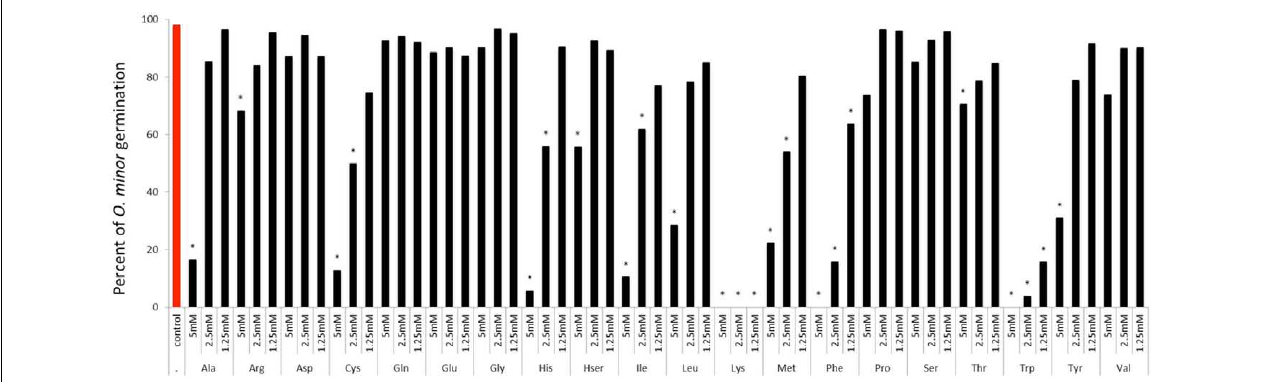
FIGURE 2 | Influence of amino acid treatments on O. minor in vitro germination. Treatment solutions of alanine, arginine, aspartate, cysteine, glutamic acid, glutamine, glycine, histidine, homoserine, isoleucine, leucine, lysine, methionine, phenylalanine, proline, serine, threonine, tryptophan, tyrosine, and valine along with a germination stimulant GR24 were applied to O. minor seeds at a range of 5–1.25 mM and their inhibitory activity in germination rated 7 days later as percentage of germination in each of three replicated disks. Analysis of variance was applied to transformed replicate data. ∗ Indicates differences of each treatment compared with the control GR24 assessed by Dunnett’s test at the 0.05